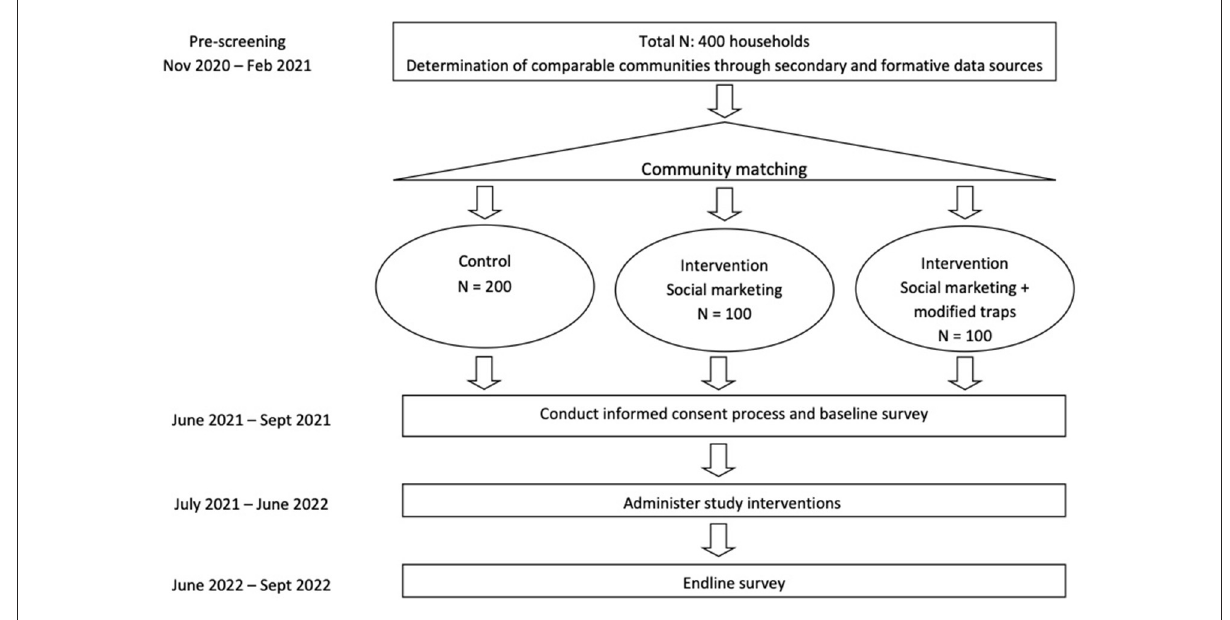
FIGURE2 Study design.